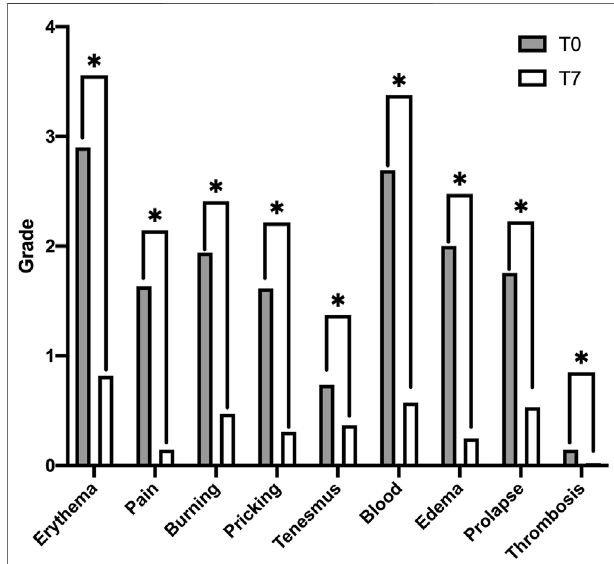
FIGURE 2 | Improvement in hemorrhoidal symptoms, in terms of grade, at the different evaluation times, at baseline (T0), and after 7 days of treatment with the study compound (T7). Data in the histogram are presented as medians. Differences in the distribution of the symptom variable, in the interval T0 – T7, and found to be statistically signi fi cant are highlighted with “ * ”